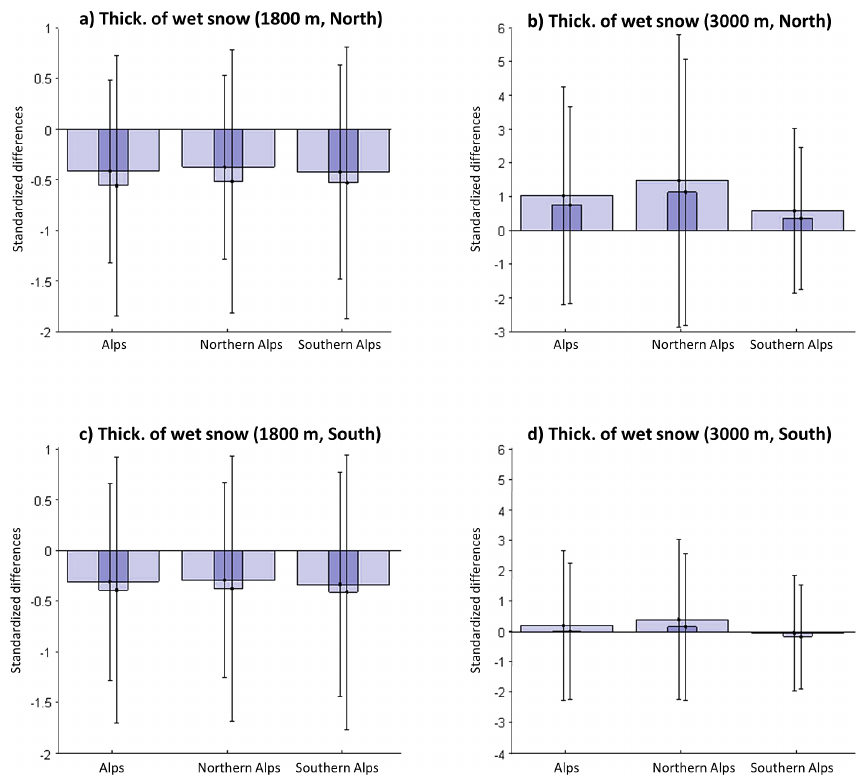
Figure 7. Same as for Fig. 4 but with regard to thickness of wet snow (north and south facing slope, at 1800 and